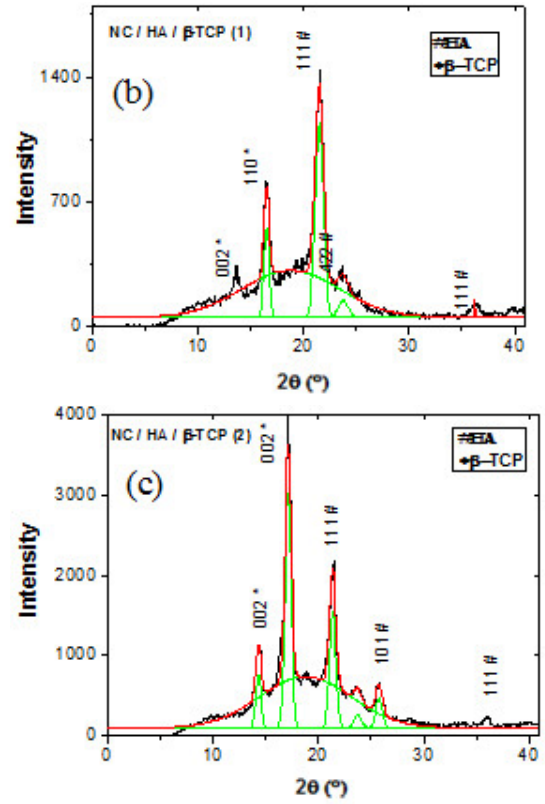
Figure 6. The composite powder structure was determined by XRD after extraction in three stages with different hydrolysis times: ( a ) 0 days; ( b ) 30 days, and ( c ) 60 days.